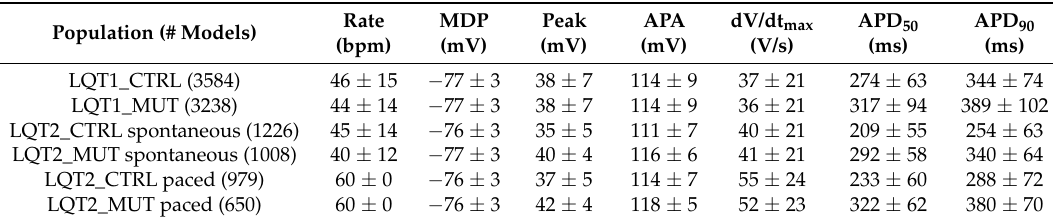
Table 1. Summary of the main AP biomarkers (mean ± SD) for the in silico hiPSC-CM populations. APA: AP amplitude. APD 50 : AP duration at 50% of repolarization. APD 90 : AP duration at 90% of repolarization. dV/dt max : maximum upstroke velocity. MDP: maximum diastolic potential.